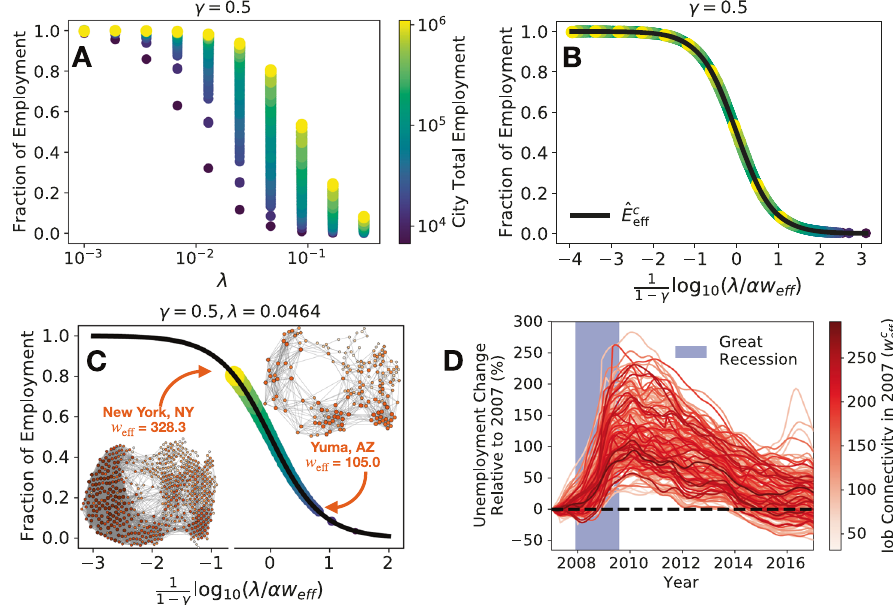
Fig. 2 Job connectivity determines a universal trend in urban resilience and predicts unemployment during the Great Recession. A The steady-state solutions of the simulation model for each city while varying the rate of job match dissolution λ . B Similar to ( A ) but controlling for the job connectivity in each city w c . Solid line is the analytically-derived employment rate at equilibrium. C The equilibrium solutions of our model for each city for λ = 0.046 and eff job network projections for two example cities given by occupations with nonzero employment in each city. In ( A – C ), symbol size and color represent total employment in the city. The color bar provided in ( A ) also applies to ( B ) and ( C ). D Unemployment by US city during and after the Great Recession. Lines are colored by the city ’ s job connectivity in 2007.